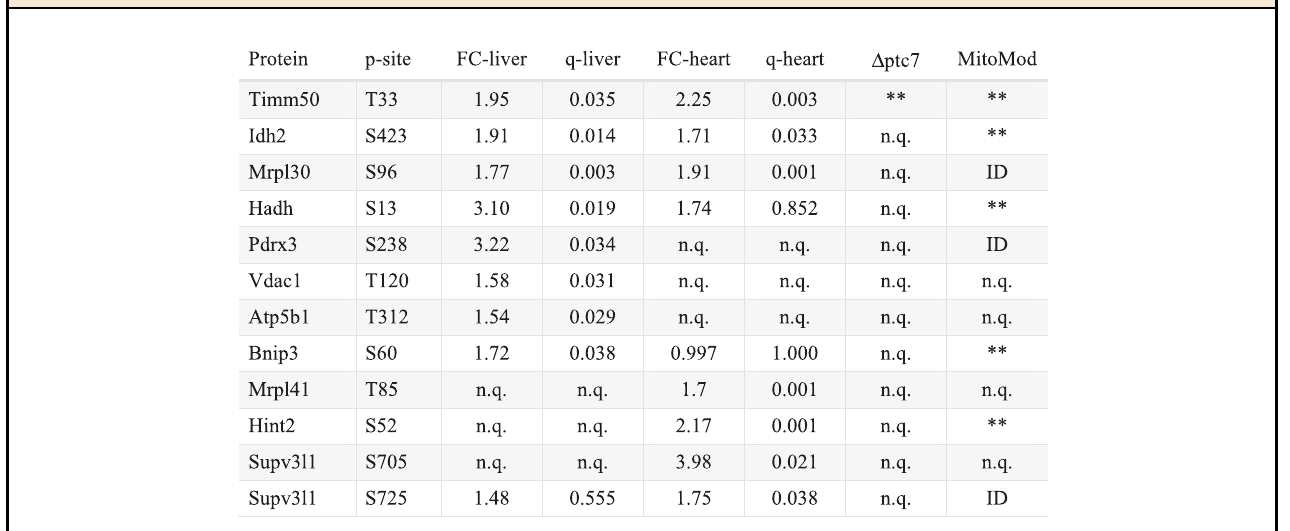
Table 1 Select Pptc7 candidate substrates across liver, heart, and knockout yeast